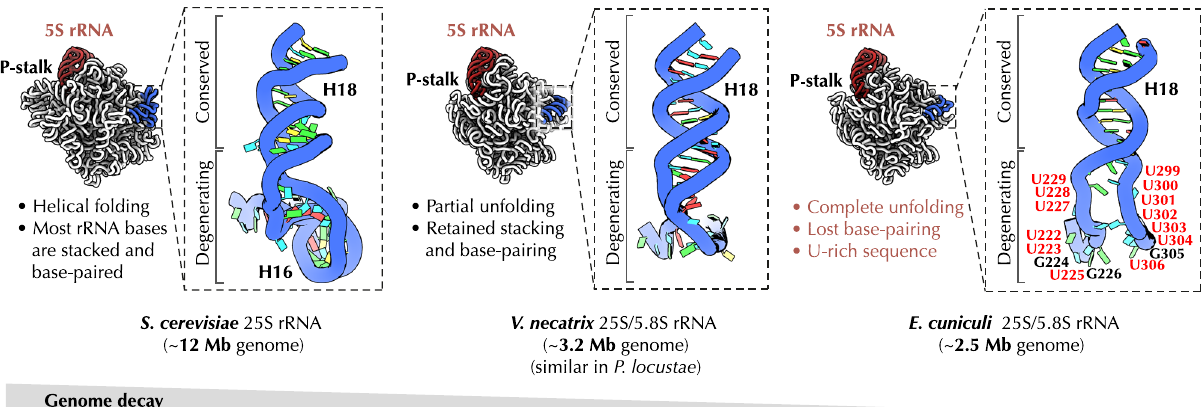
Fig. 3 Microsporidian rRNA trades favorable folding for minimal length. Structure of the helix H18 of the 25 S rRNA in S. cerevisiae , V. necatrix , and E. cuniculi . Typically, in ribosomes across the three domains of life, this linker is folded into an RNA helix, which comprises between 24 and 34 residues. By contrast, in microsporidia this rRNA linker is being progressively reduced to two, single-stranded uridine-rich linkers that comprise just 12 residues. Most of these residues are exposed to the solvent. This fi gure illustrates that microsporidian parasites appear to defy a common principle of rRNA folding, in which rRNA bases are typically paired with other bases or involved in rRNA – protein interactions. In microsporidia, some rRNA segments adopt unfavorable folding, in which former rRNA helices are turned into single-stranded segments that are stretched out almost into a straight line. Having these unusual stretches allows microsporidian rRNA to connect distant segments of rRNA using the minimal number of RNA